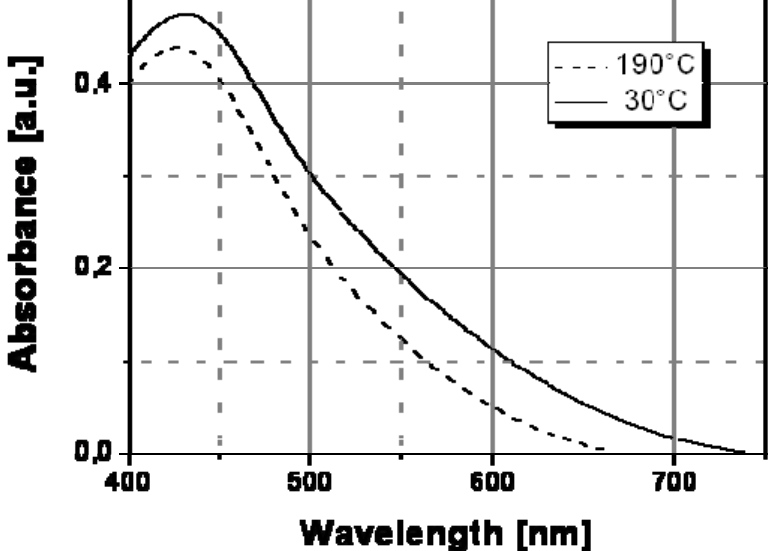
) SAg in amorphous 2 11